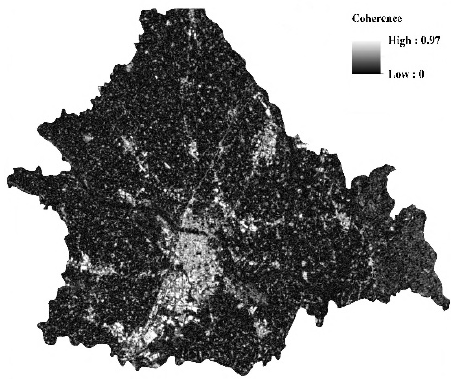
Figure 12. Sentinel-1 coherence map after